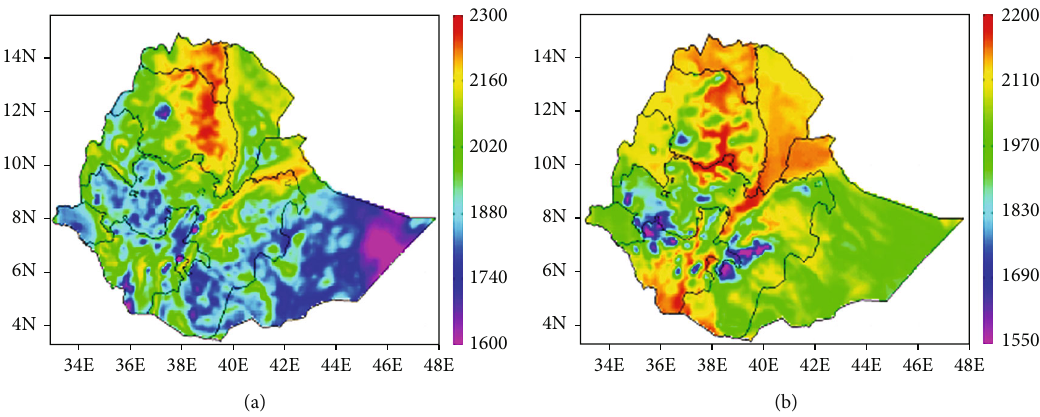
Figure 9: Average annual total solar radiation, kW · h/(m 2 · a): (a) 1980-1989; (b)